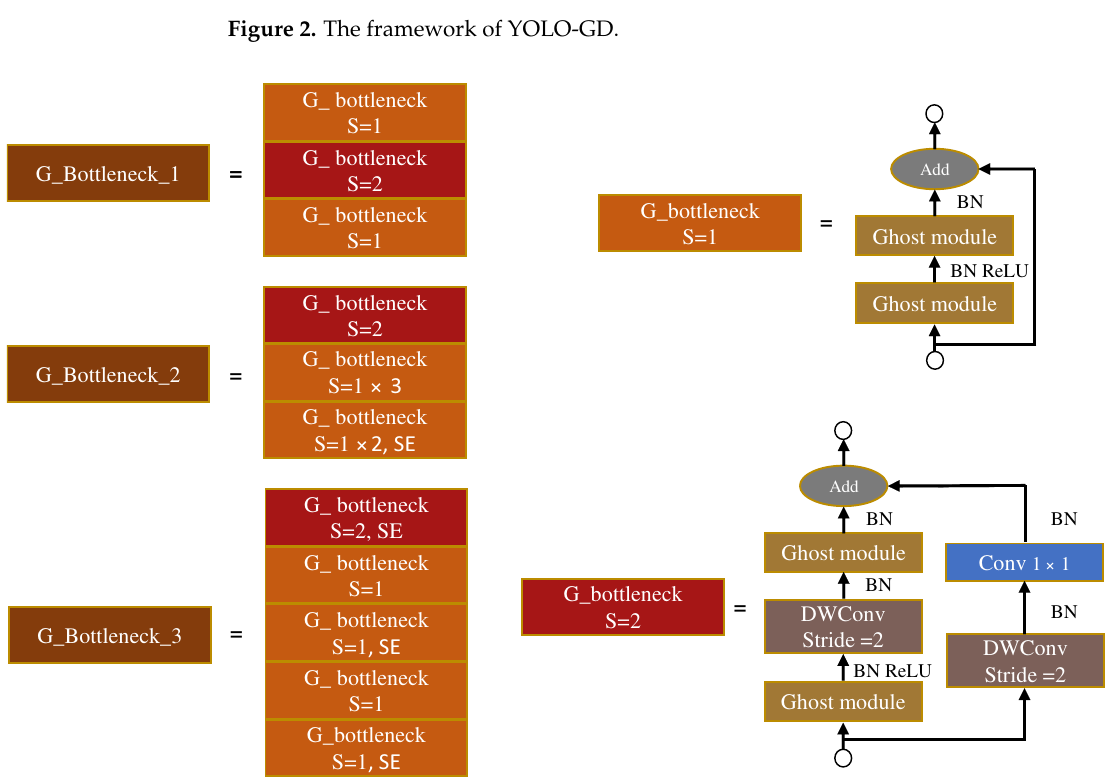
Figure 3. Detailed explanation of feature extraction